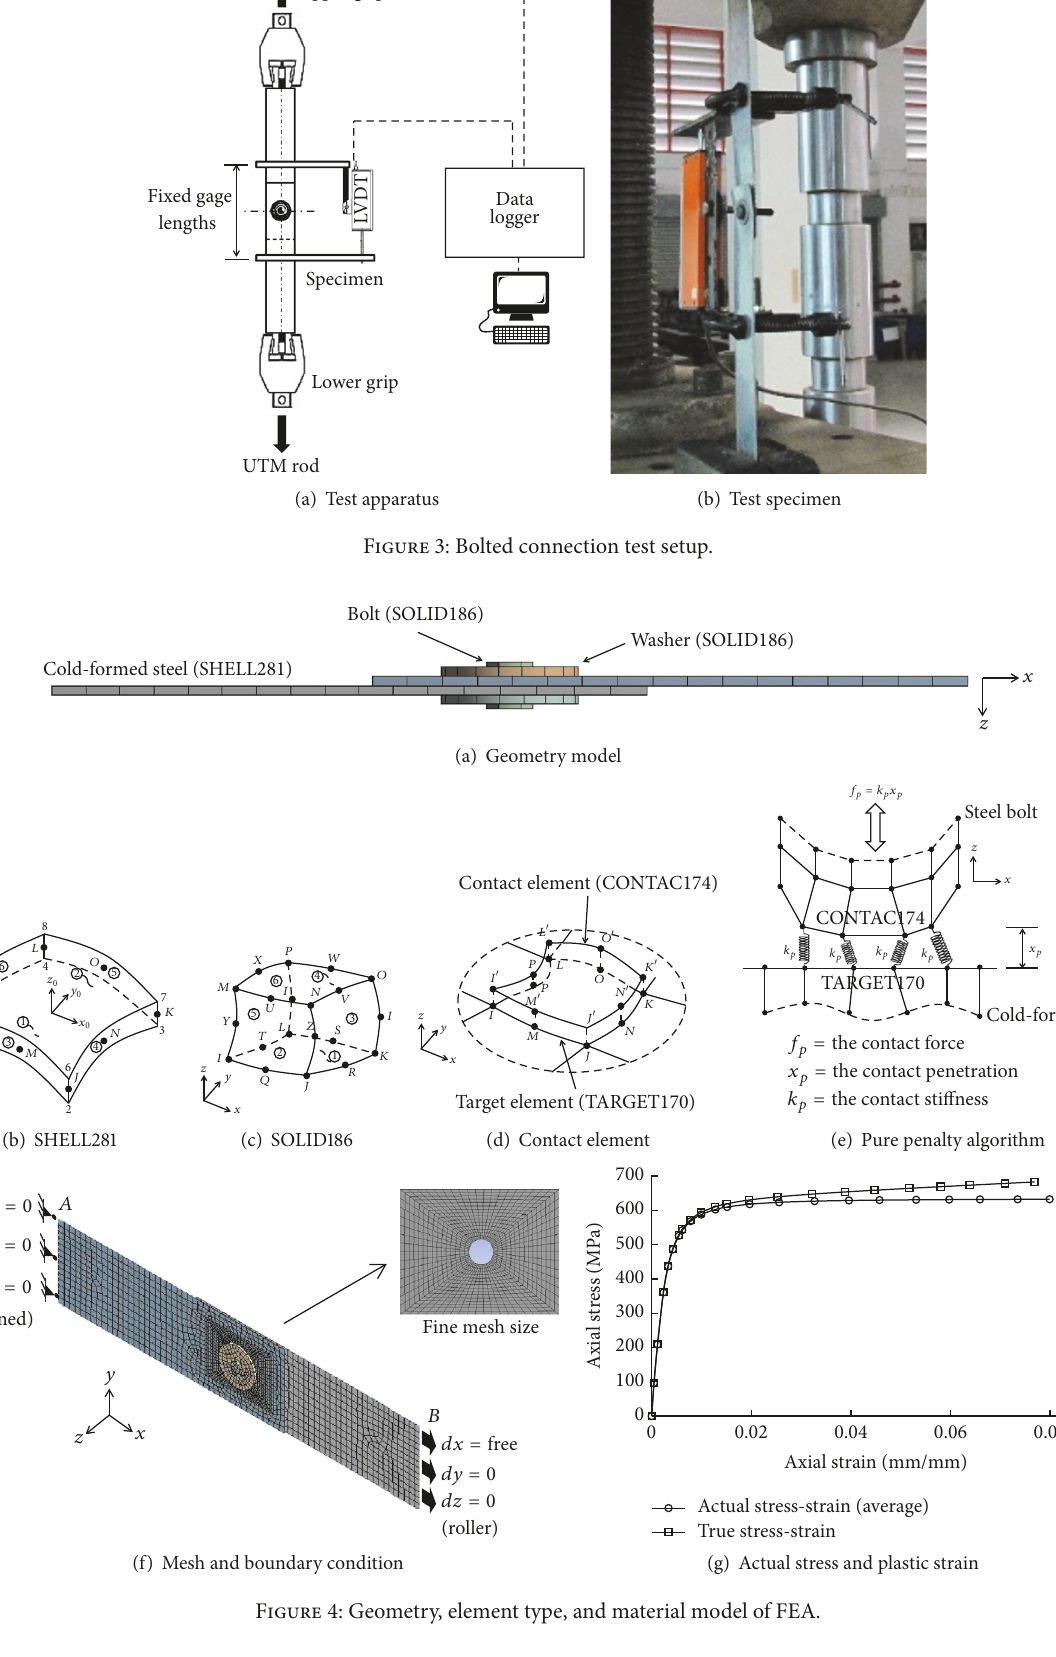
Figure 4: Geometry, element type, and material model of